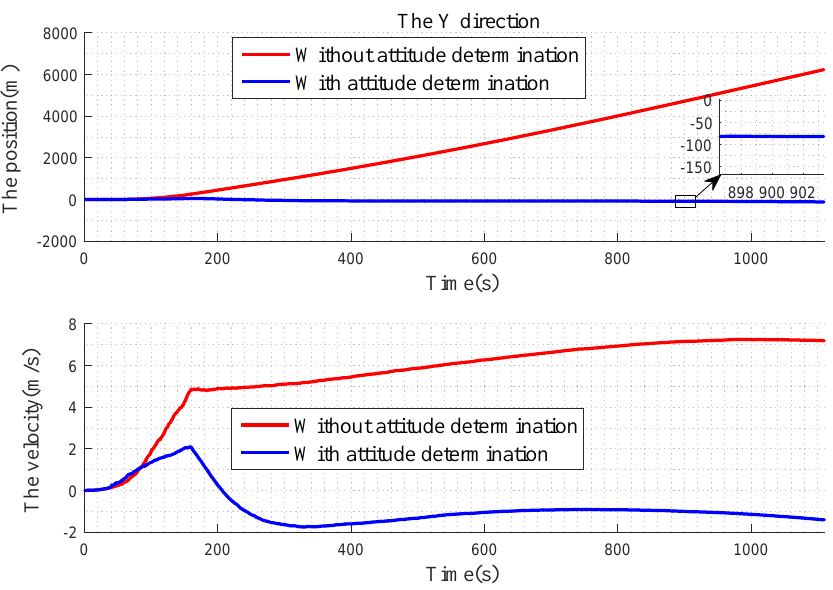
Figure 12. Precision comparison of the X direction.